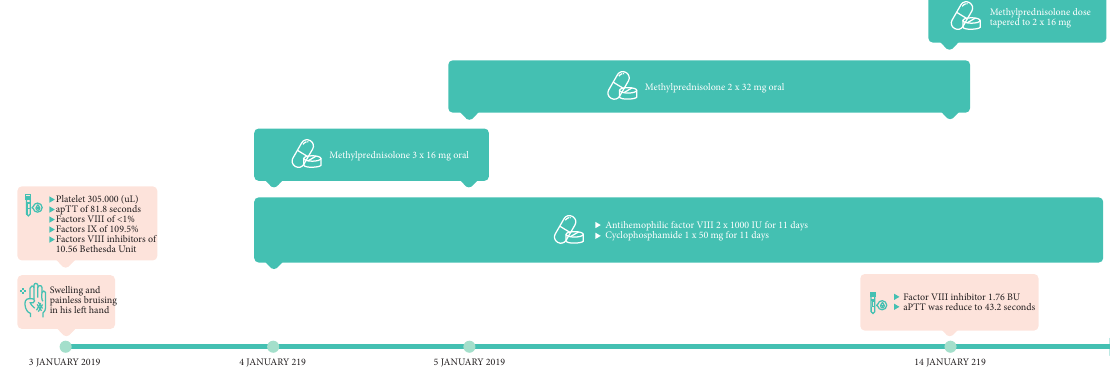
Figure 3: Timeline of events and interventions for case 3.